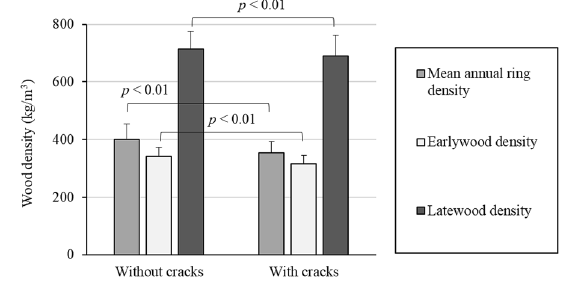
Fig. 8 Comparison of annual ring density in logs with and without cracks